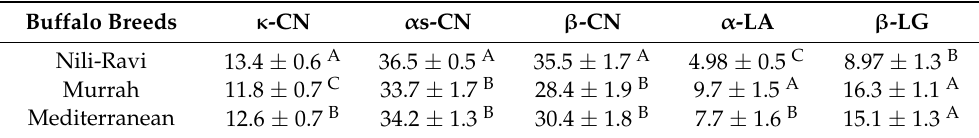
Table 6. Protein fractions of milk from different buffalo breeds (as a percentage of total milk pro- tein content). Buffalo Breeds κ -CN α s-CN β -CN α -LA β -LG Nili-Ravi 13.4 ± 0.6 A 36.5 ± 0.5 A 35.5 ± 1.7 A 4.98 ± 0.5 C 8.97 ± 1.3 B Murrah 11.8 ± 0.7 C 33.7 ± 1.7 B 28.4 ± 1.9 B 9.7 ± 1.5 A 16.3 ± 1.1 A Mediterranean 12.6 ± 0.7 B 34.2 ± 1.3 B 30.4 ± 1.8 B 7.7 ± 1.6 B 15.1 ± 1.3